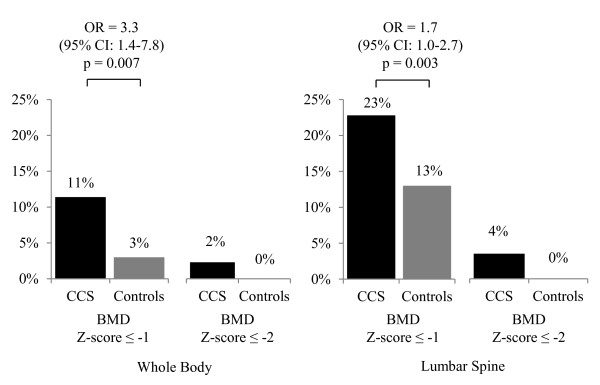
Whole body and lumbar spine bone deficits in childhood cancer survivors (CCS) compared to controls. Odds ratio (OR) adjusted for sex, age-at-study, ethnicity (white-not-Hispanic, others), and pubertal Tanner stage are presented for BMD Z-score ≤ -1; OR for BMD Z-score ≤ -2 unable to be calculated due to 0% prevalence in controls.